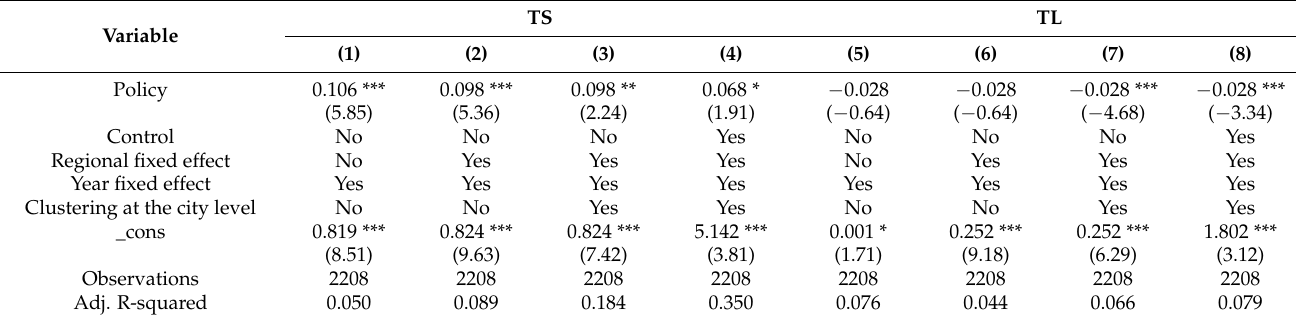
Table 9. Effects of low-carbon city construction (LCC) on upgrading of industrial structure.